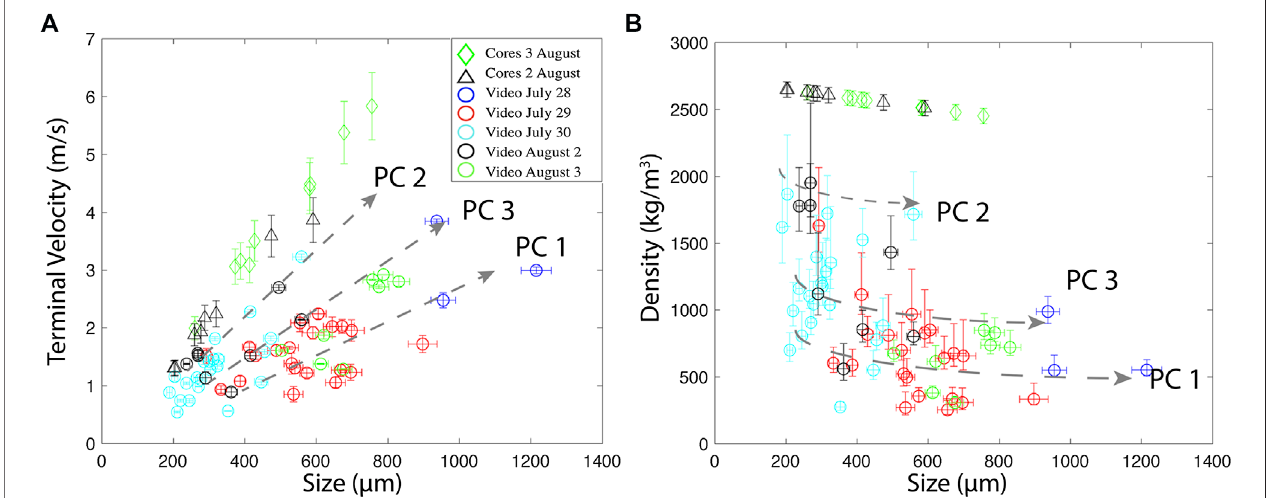
FIGURE 5 | Aerodynamic properties of aggregates (circles) and aggregate cores (triangles and diamonds) analyzed with HS-HR camera (colors refer to the day of collection). Terminal velocity of aggregates is measured directly from videos; terminal velocity of cores is calculated with Eq. 2 based on the density derived from the density-size trend obtained by Bagheri et al. (2016). (A) Terminal velocity against size, and (B) aggregate density against size. Dotted arrows de fi ne different aggregate types in the space velocity-density-size determined based on visual observations (see main text for more details).